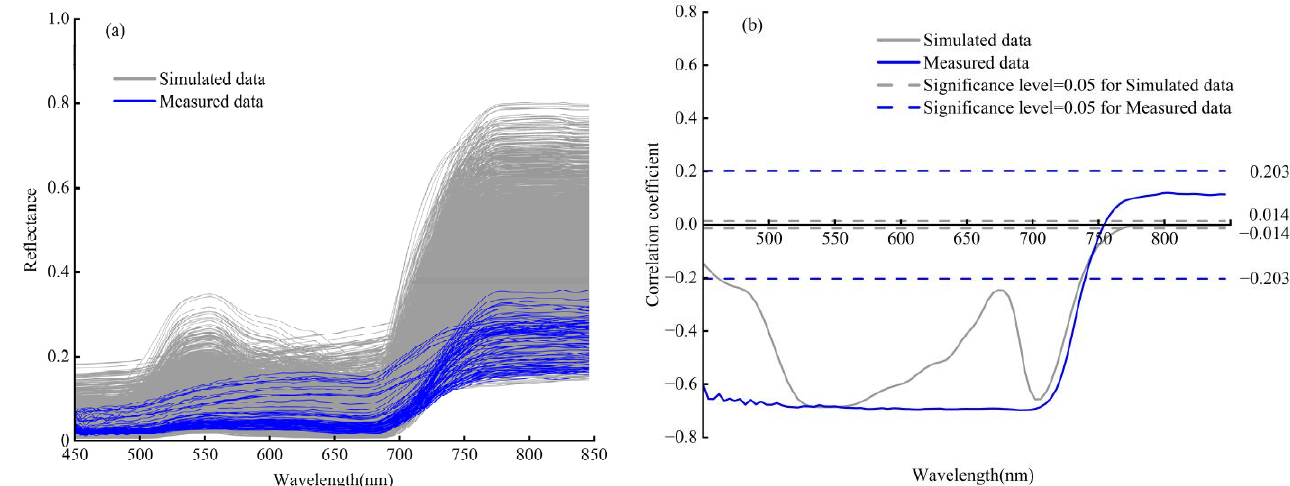
Figure 4. Simulated and measured spectral reflectance curves ( a ) and the correlation coefficients between each band in simulated spectrum and LNC and between each band in measured spectrum and LNC ( b ).